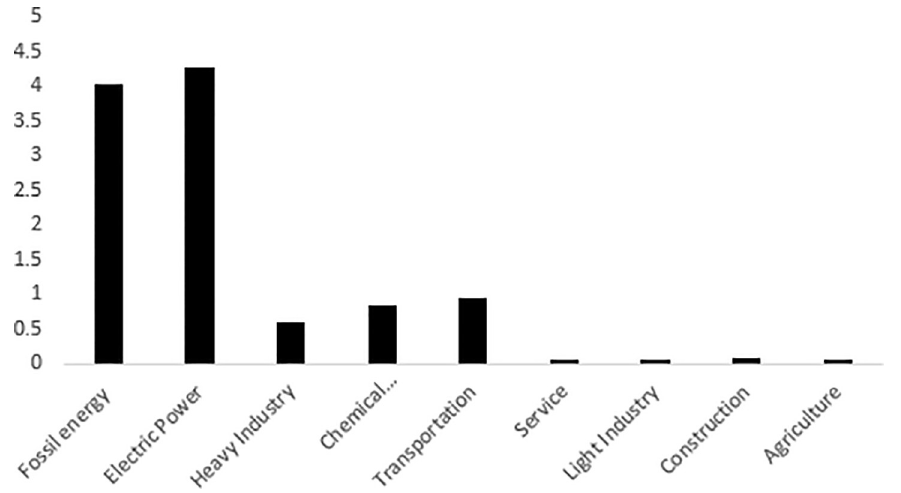
Fig 4. Carbon emission efficiencies of nine